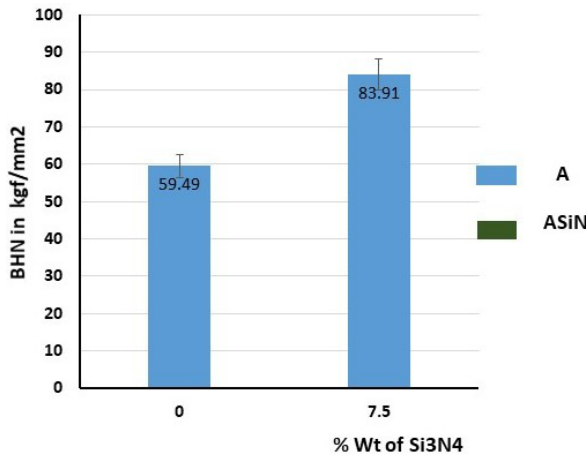
Figure 9: Hardness values of Base metal ‘A’ and ASiN reinforced